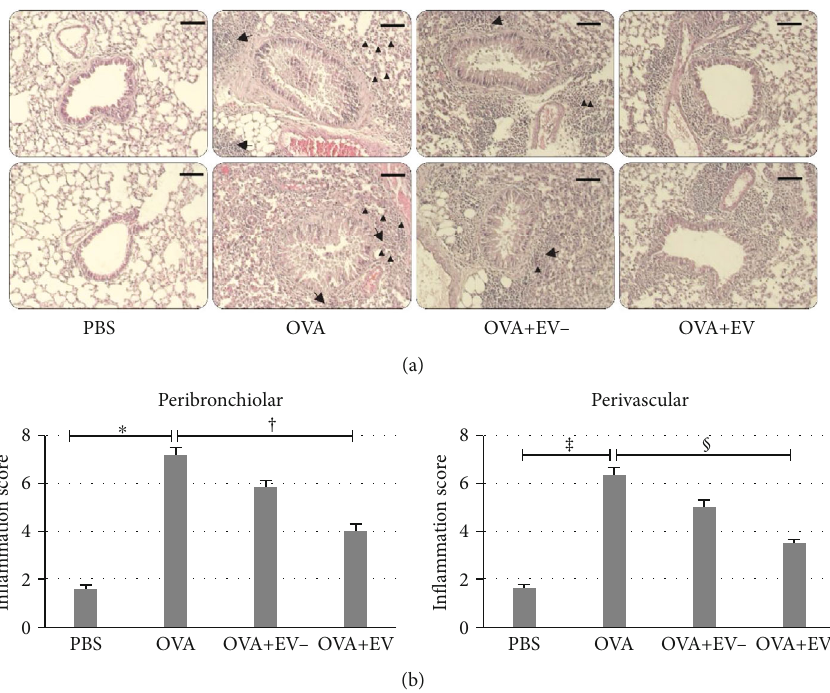
Figure 4: E ff ects of adipose stem cell- (ASC-) derived extracellular vesicles (EVs) on lung histology and in fl ammation scores. (a) In fi ltration of in fl ammatory cells (black arrow) and eosinophils (black arrowhead) showed a greater decrease in the OVA+EV group than in the OVA group. The scale bar indicates 100 μ m. (b) The in fl ammation score decreased signi fi cantly in the OVA+EV group compared with the OVA group around peribronchiolar and perivascular areas. Data are expressed as the mean ± SEM of four independent experiments, each performed in triplicate. ∗ , † , ‡ ,§ p < 0 : 001 .